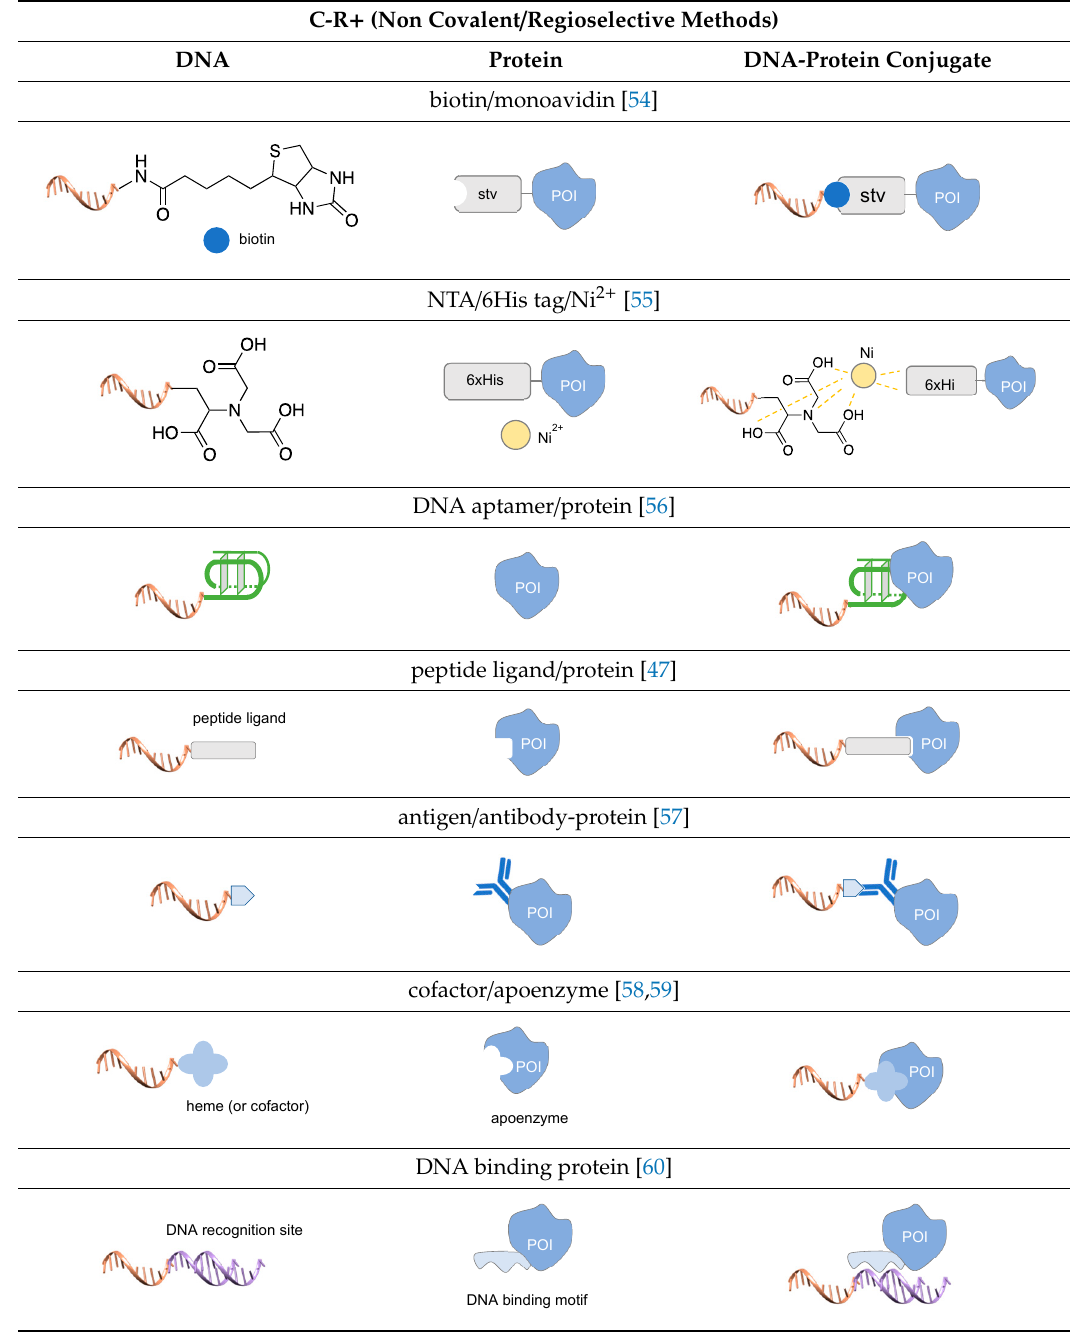
Table 4. Representative non-covalent and regioselective (C-R+) DNA-protein conjugation methods.